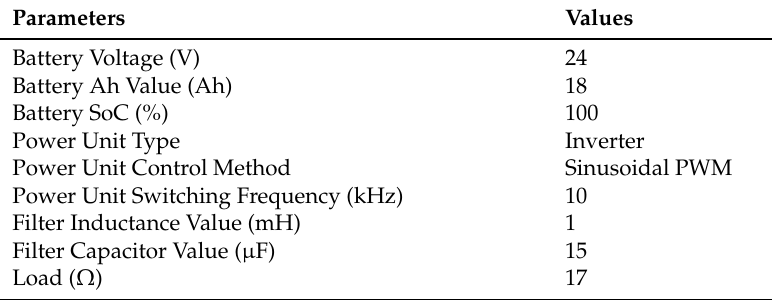
Figure 7. Photograph of the test platform. Table 2. Parameters of the test